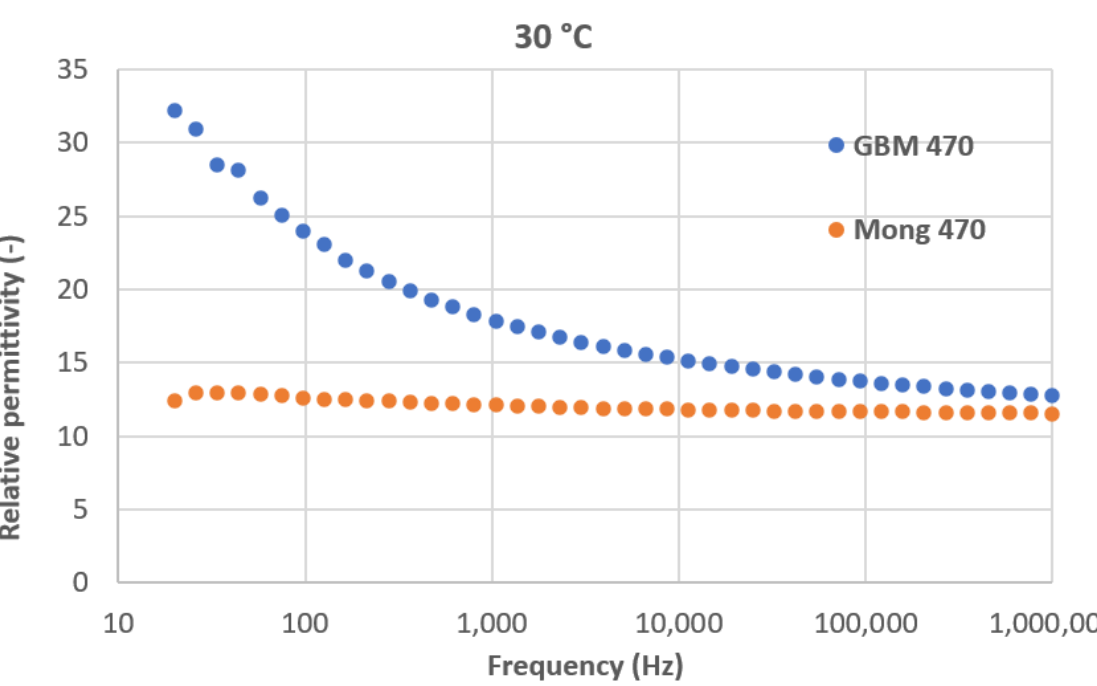
Figure 9. Relative permittivity dependence on frequency at room temperature for coatings sprayed with SD 470.